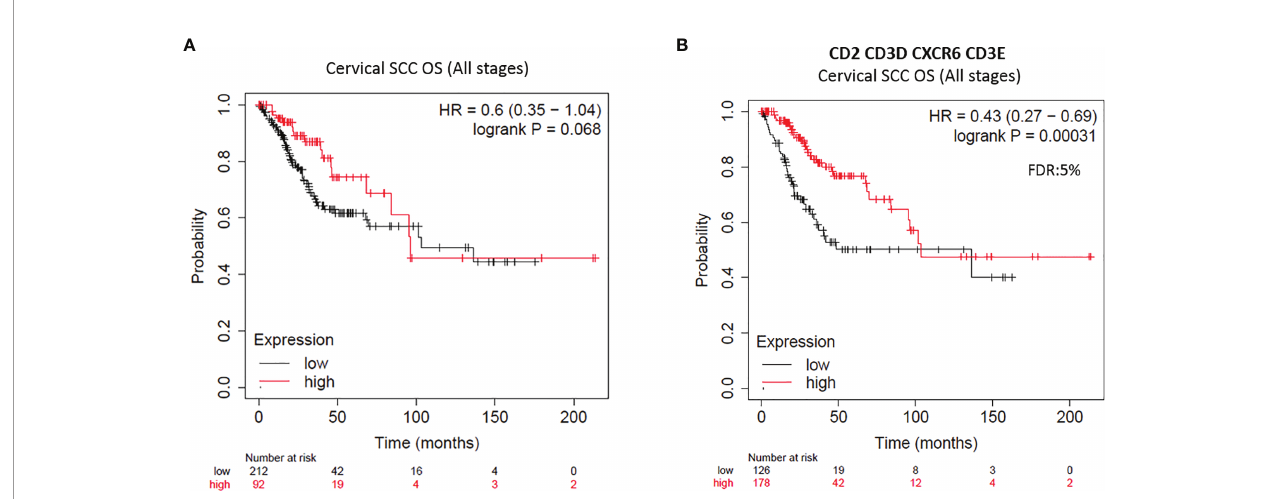
FIGURE 5 | Expression of CD2 , CD3D , CD3E , CXCR6 immune gene combination shows better clinical outcome of CSSC patients. Clinical outcome of survival plots in CSCC at all stages (n = 254) with transcriptomic expression of all four previous published immune signatures (A) and with the new immune gene-set combination CD2 , CD3D , CD3E , CXCR6 (HR < 0.65 and FDR = 5%) (B) . HR for risk of death and OS are displayed. HR < 0.65 discriminates a risk reduction. FDR is also